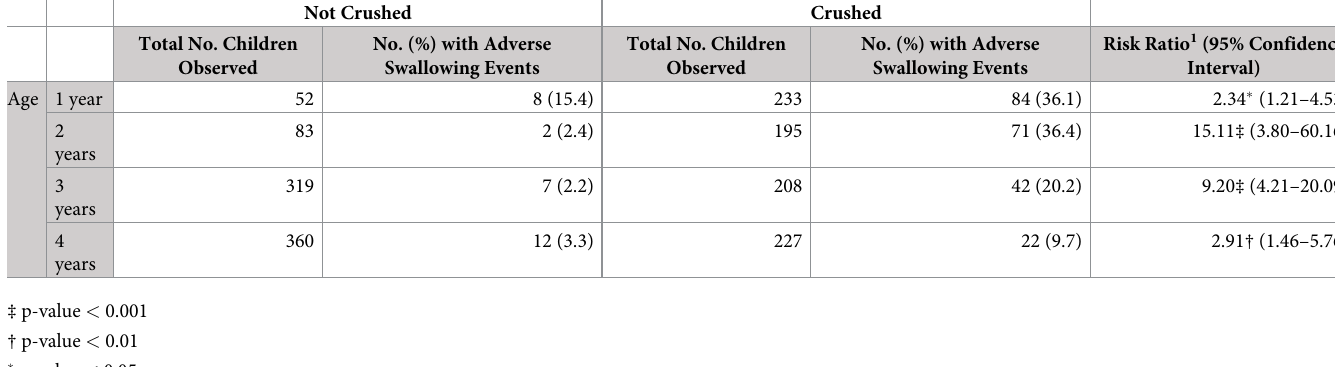
Table 2. Number and percentage of children with adverse swallowing events, by child age and tablet form (crushed or not crushed). Not Crushed Crushed Total No. Children